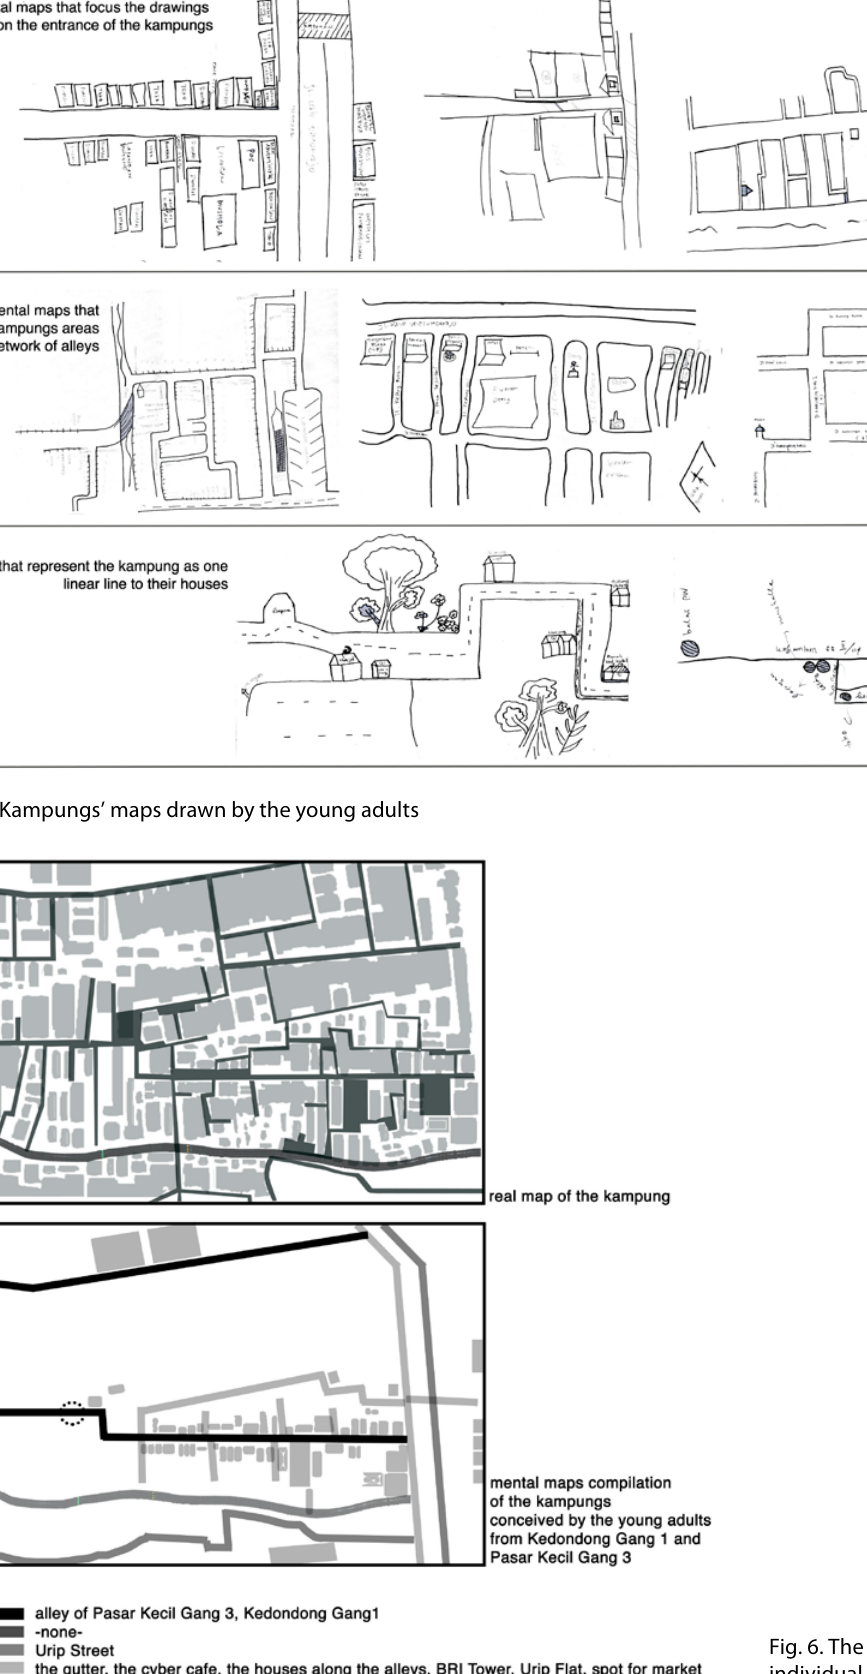
fig. 6. The compilation of individual mental maps of the